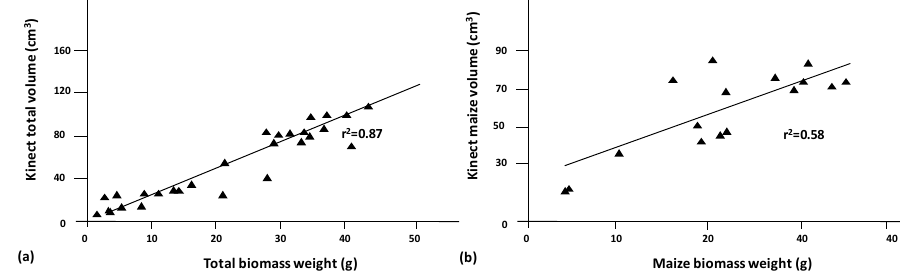
Figure 5. Linear regression between both the total volume that was estimated using the Kinect v2 sensor and the total biomass ( a ) and the maize volume with the maize biomass ( b ). The R 2 denotes the correlation coefficient of the simple regression.